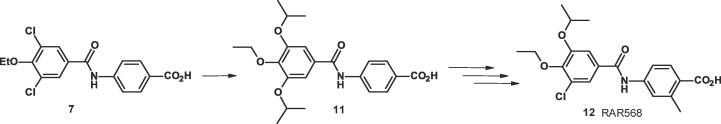
Lead optimisation.